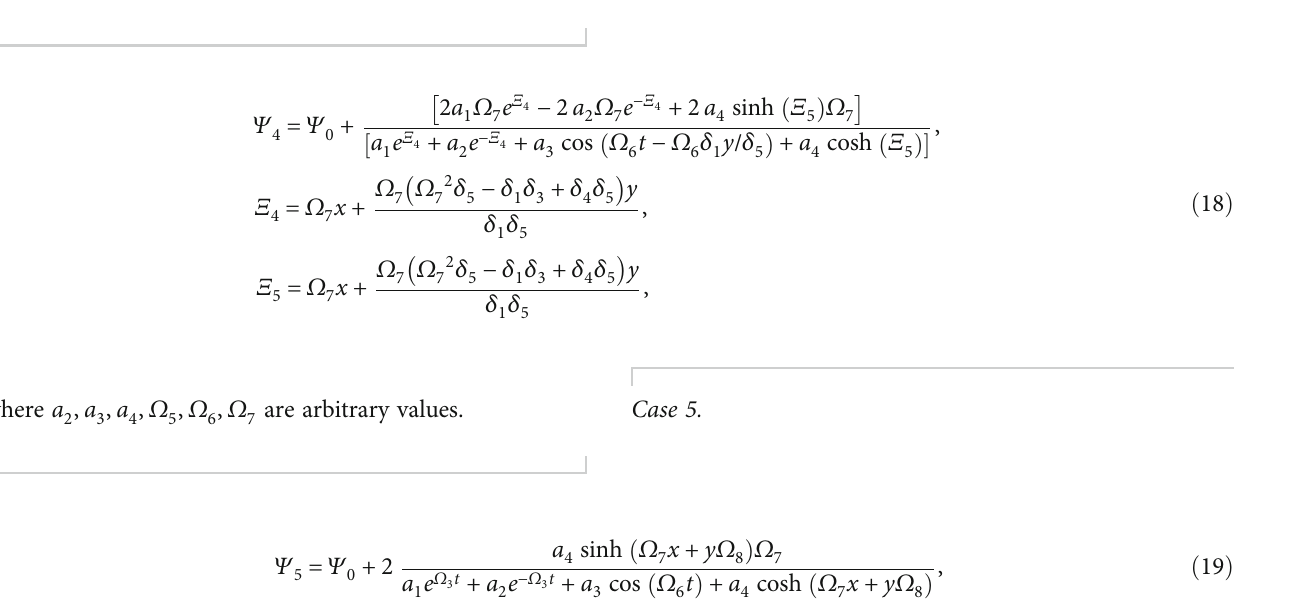
Figure 1: Plot evolution of periodic waves (12) utilizing values a = 2, δ = 1 : 3, δ = 2, Ψ = 1, t = 10 and (a) 3D plot, (b) density plot, and (c) contour 4 5 0